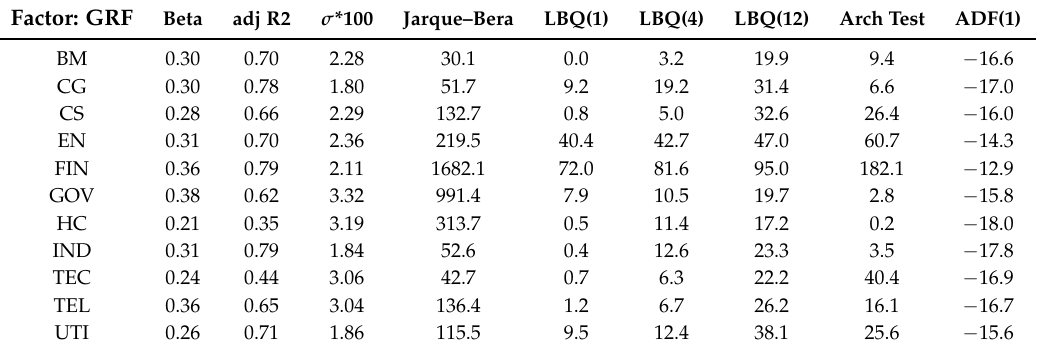
Table 8. One-factor Global Risk Factor (GRF) regressions explaining sectorial credit indices. Factor: